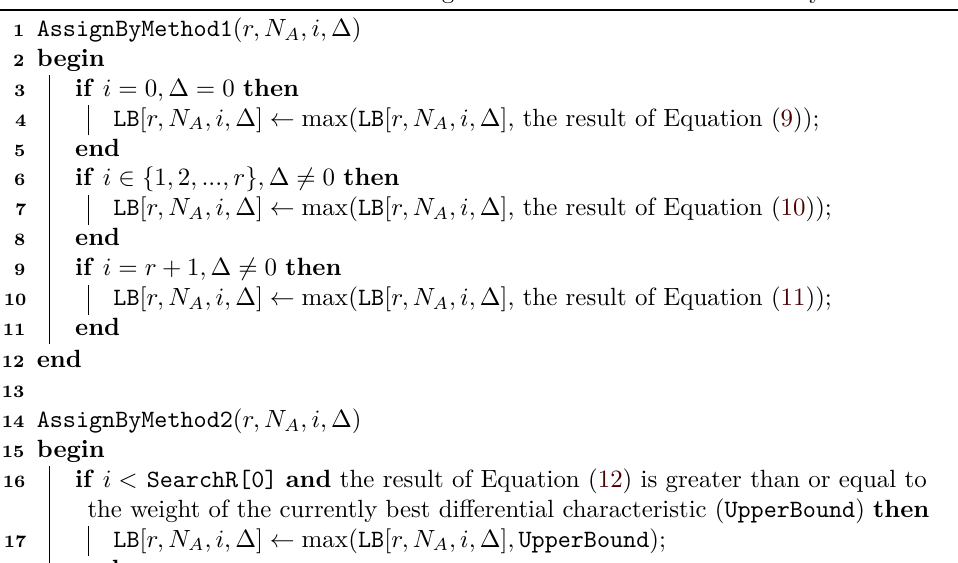
Function Three functions used to assign values to the lower bound